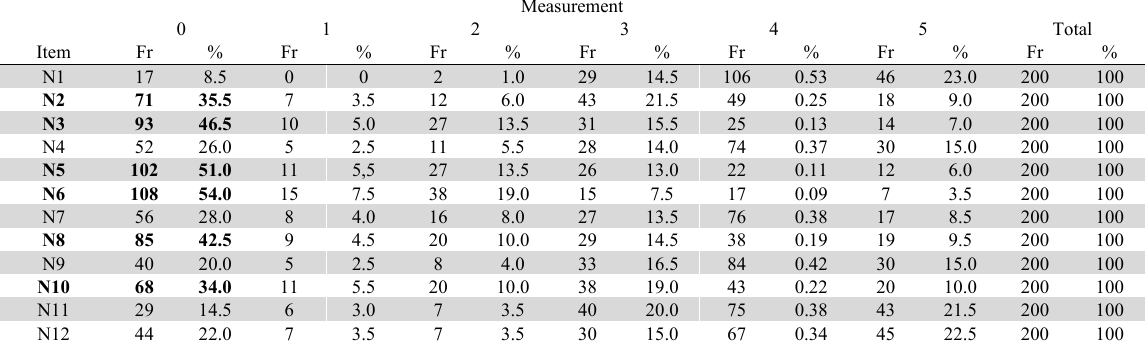
Frequency of Items which Not Carried Out by